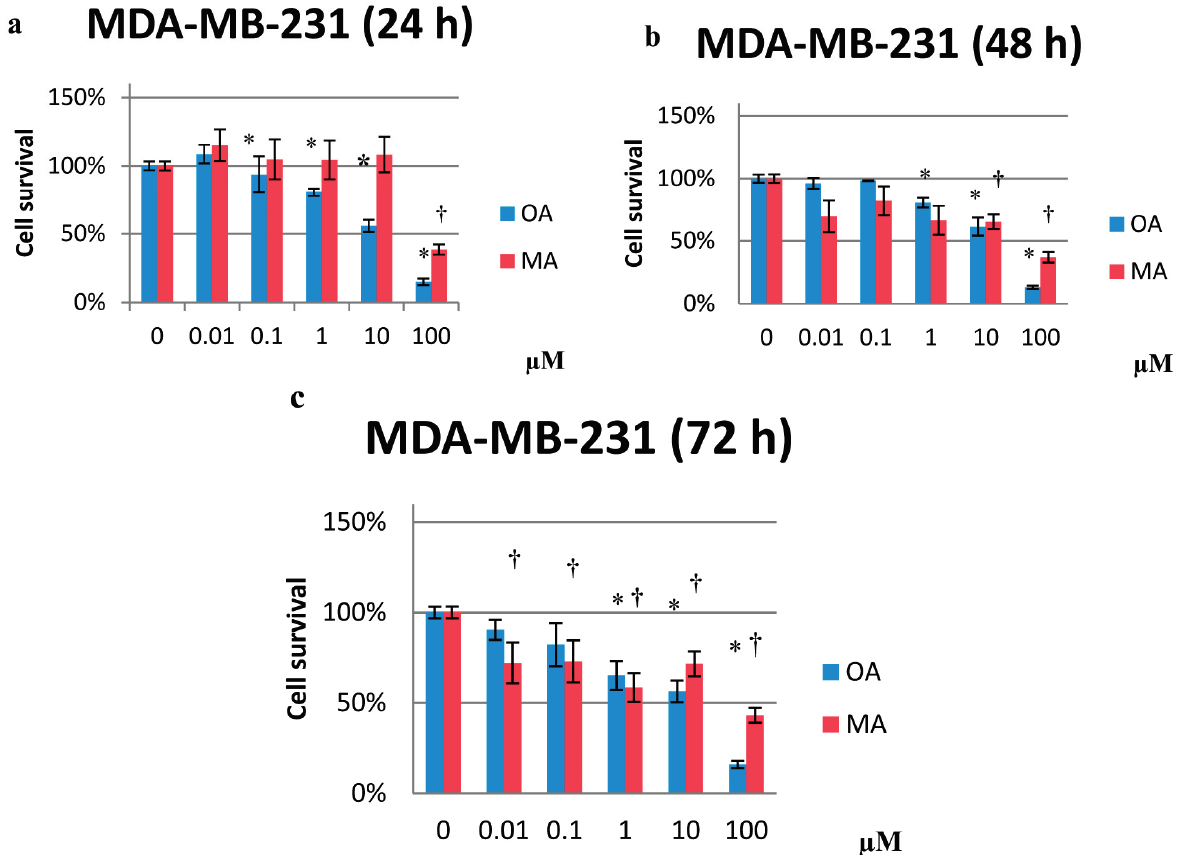
Figure 4. Percentage of cell proliferation in MDA-MB-231 cells after treatment with 0.01 µM to 100 µM OA or MA for 24 ( a ); 48 ( b ) and 72 h ( c ). Values represent the mean ± SEM of three independent experiments. Statistically significant differences are represented by (*) for OA and (†) for MA at p < 0.05 with respect to the untreated